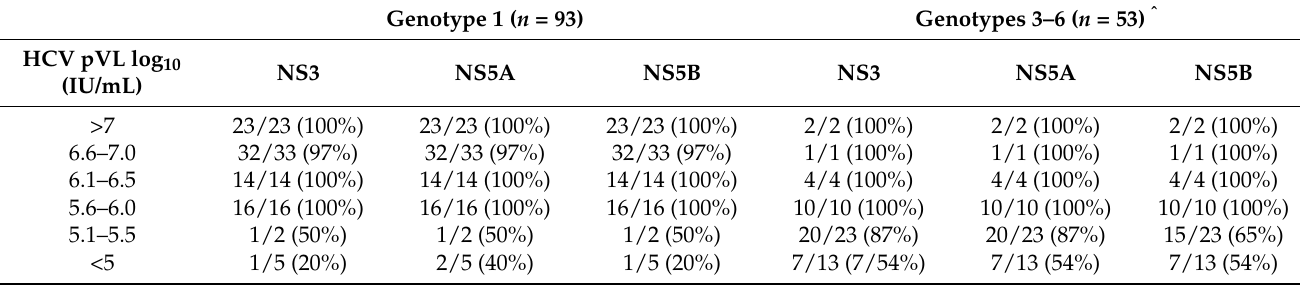
Table 2. Sequencing success of the genotype-independent NGS assay in GT1 and GT3-6 sample sets stratified by viral load